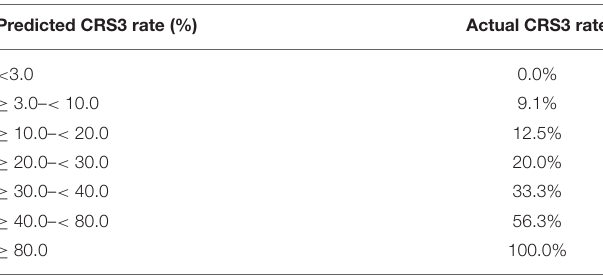
TABLE 4 | The possibility of chemotherapy response score 3 by nomogram prediction and actual rate in patients treated with neoadjuvant